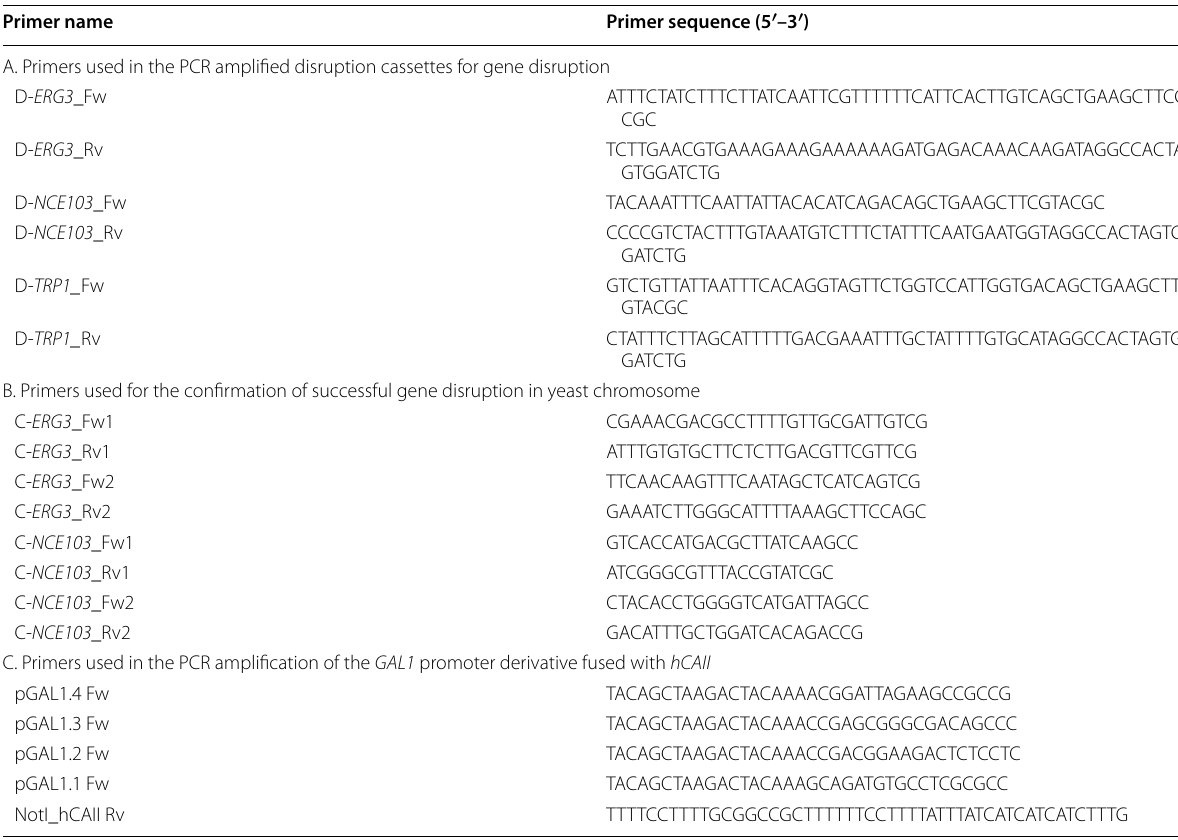
Table 3 Oligonucleotide primers used in this